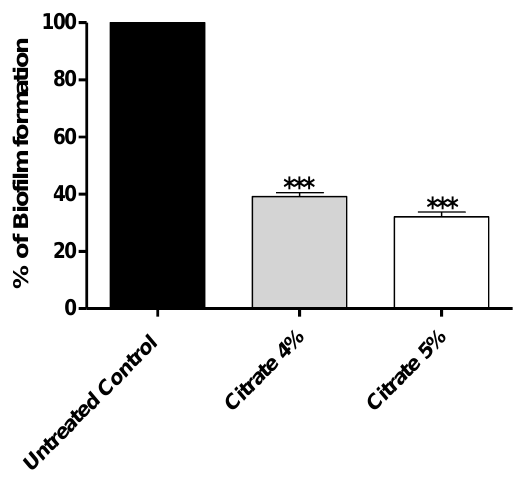
Figure 2. The effect of sodium citrate at 4% or 5% on the biofilm formation. Citrate at 4% or 5% significantly diminished the biofilm formation; the inhibition percentages were 61% and 68%, respectively. The data are presented as percentage change from control, and One-way ANOVA test was employed to assess significance; ***: p ≤